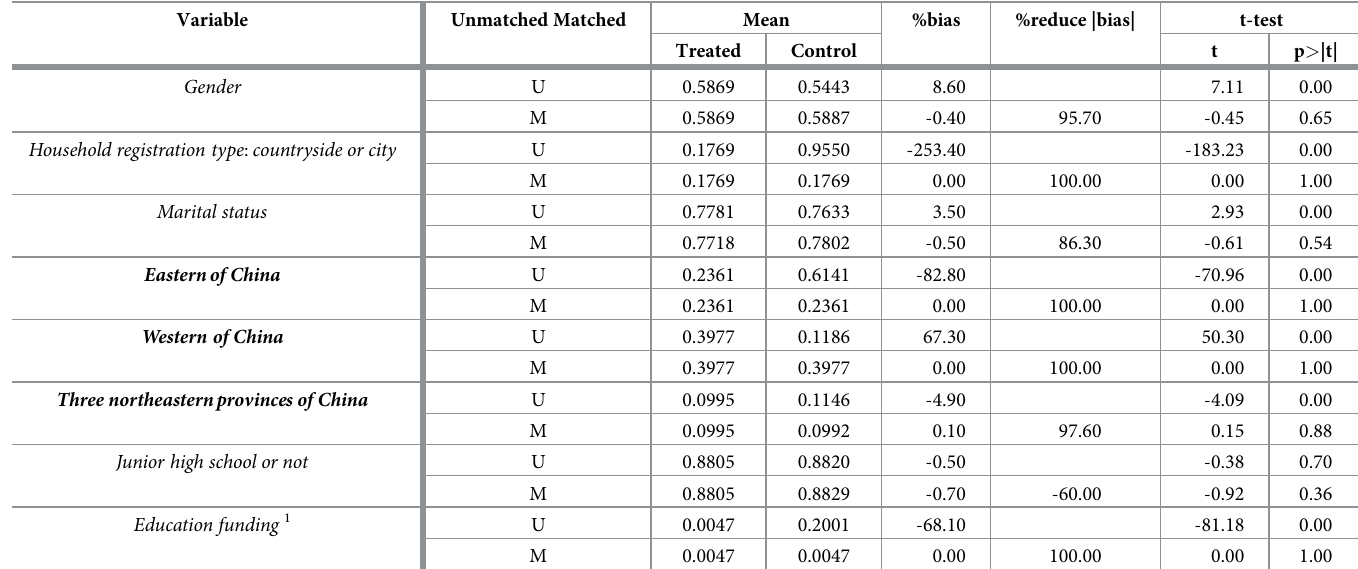
Table 5. The results of the balancing test-1.